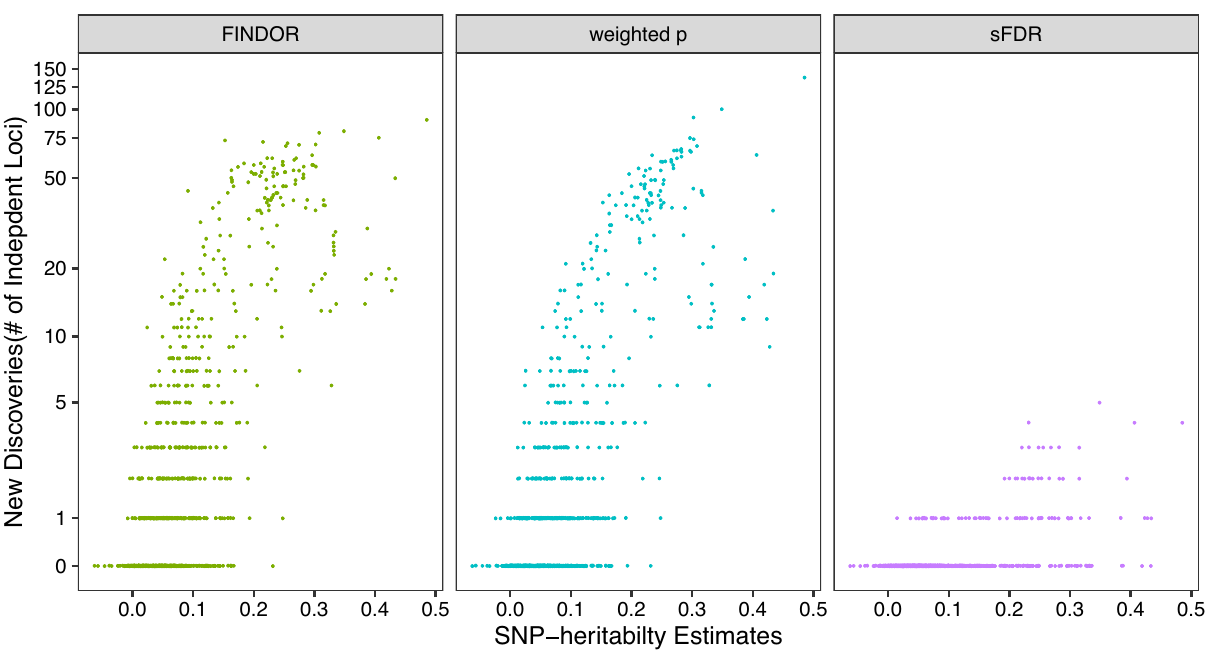
Figure 5. The total numbers of genome-wide significant independent loci of the UK Biobank GWAS application study, before and after data-integration with functional annotations, stratified by the four phenotype categories. In each figure, the total number of significant loci identified based on the UK Biobank GWAS data alone serves as a baseline. The GWAS baseline box-plot is followed by the box-plots for the total numbers of significant loci after integrating the UK Biobank GWAS summary statistics with functional annotations using FINDOR (using 75 individual annotation scores), and the weighted p value and stratified FDR control methods (each using the CADD meta-score), analyzing 7,895,174 variants for each of the 1132 UK Biobank traits. The 1132 traits were rated by Nealelab as having medium to high confidence for their heritability estimates, and they fall into four categories: nonsig (182 traits; heritability testing p value p > 0.05 ), nominal (277 traits; p < 0.05 ), z4 (235 traits; p < 3.17 Independent loci were defined using PLINK’s LDclumping algorithm with a 1 Mb window and an r 2 threshold of